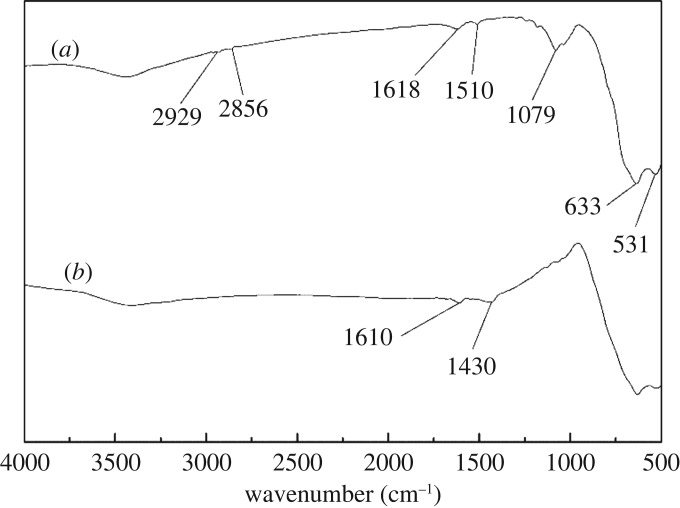
Effect of Mg2+ on the adsorption of OHA on cassiterite: (a) cassiterite conditioned in OHA at a pH of 9.0; (b) cassiterite conditioned in Mg2+ and OHA.